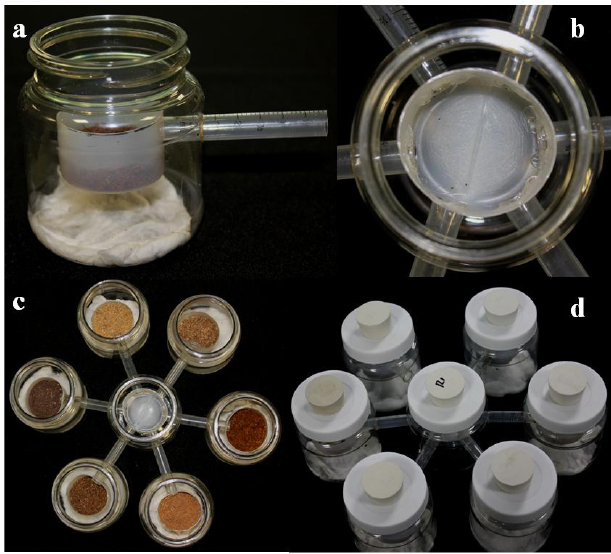
Fig 1. Device for high RH and preference of termites towards different substrates. a) Radial small environmental chamber, with suspended vial; b) Central chamber for release of termites with vial connected to six radial small environmental chambers; c) device with the six substrates for multiple choice; d) device with modified caps for HR